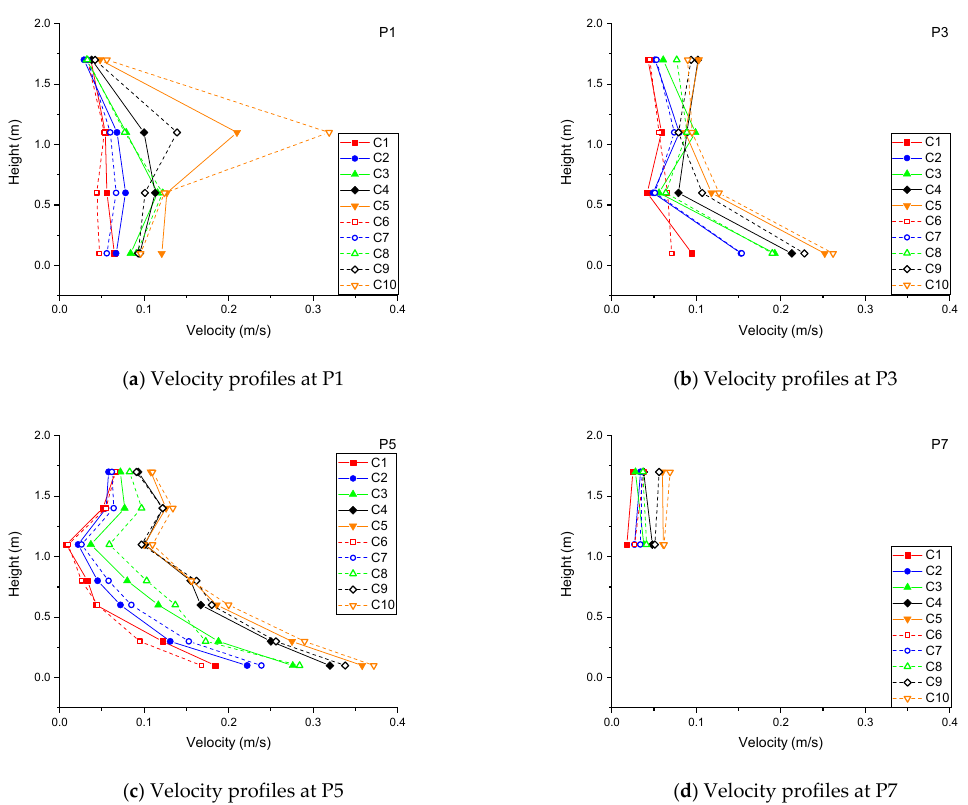
Figure 6. Velocity profiles at position P1 ( a ), P3 ( b ), P5 ( c ) and P7 ( d ) for cooling cases (C1–C10).